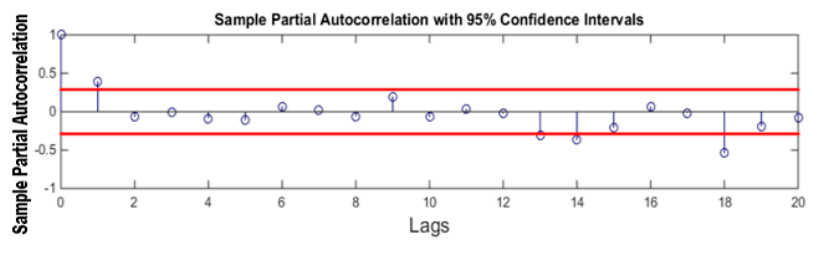
Figure 13. PACF Plot.